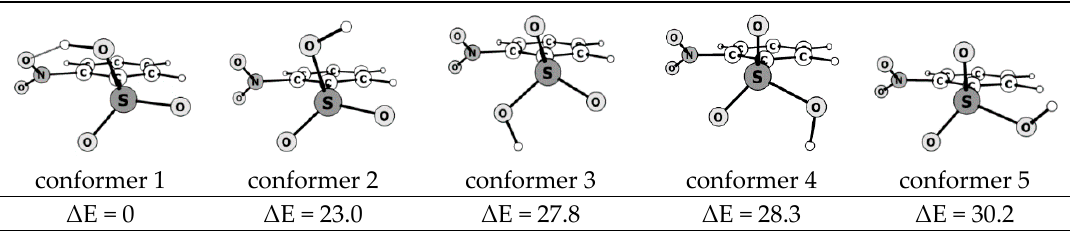
Figure 2. The structure of the 2-NO 2 -BSA conformers and their relative energies (kJ mol − 1 ).